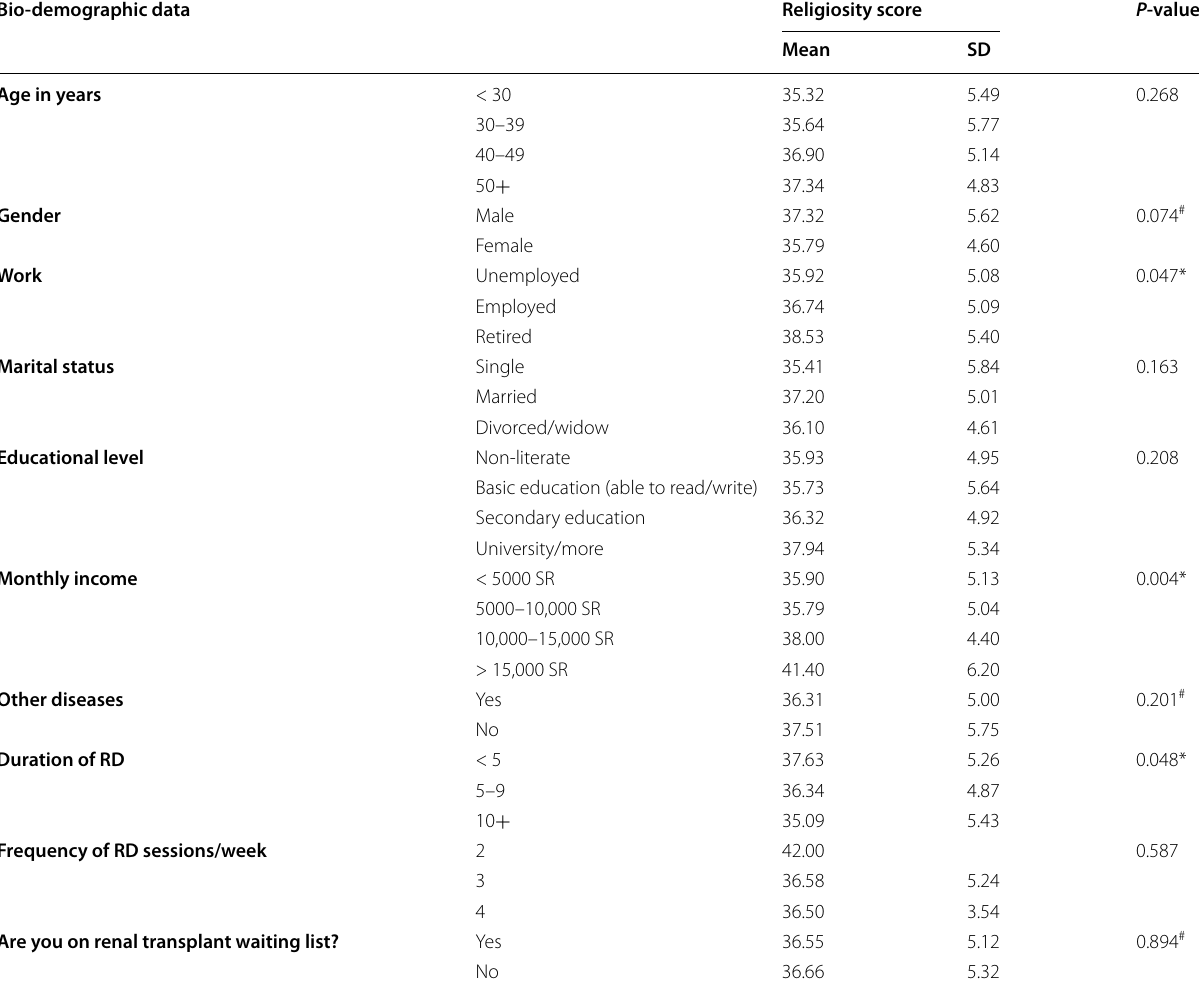
Table 5 Religiosity among haemodialysis patients by their bio-clinical data, Saudi